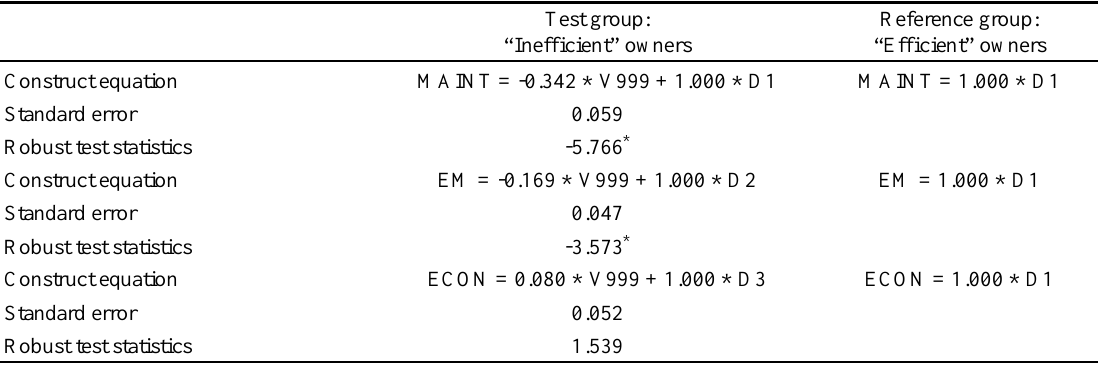
Table 3. Testing for differences in the adoption of the MAINT, EM, and ECON concepts between inefficient and efficient owners (reference group) with mean and covariance structure analysis (MACS). Values besides the constant (V999) in the construct equations are factor intercepts and represent concept means. Concept means in reference group are always zero. MAINT = maintenance forest management; EM = ecosystem-centered management; ECON = economics-centered